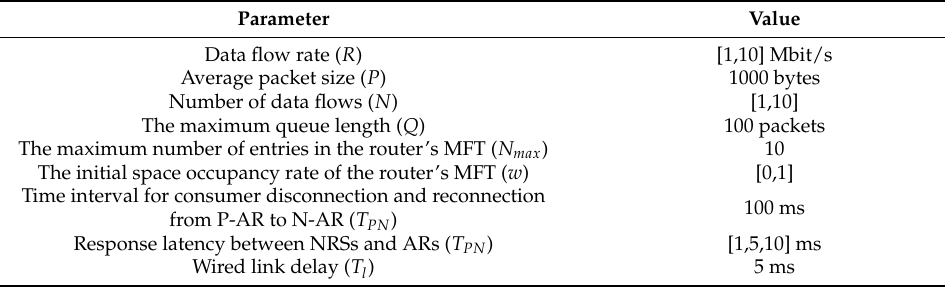
Table 2. Experiment parameters and values.